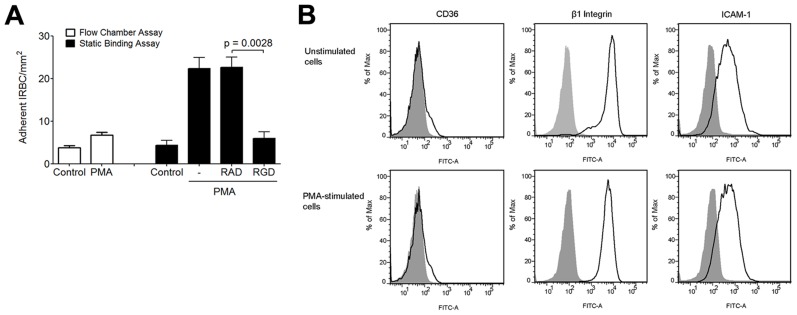
Effect of PMA on IRBC adhesion to HMEC-1.(A) Adhesion of IRBC on untreated HMEC-1 or HMEC-1 pre-incubated with PMA 50 ng/ml for 30 min at 37°C and 5%CO2 under flow (left) or static (right) conditions. In the static binding experiments, monolayers were pre-treated with either 50 ng/ml of PMA alone, or 100 µM RGD or RAD peptide was added after 10 min of incubation. At the end of 30 min, 1 ml of a 1% hematocrit suspension of IRBC in RPMI at 5–9% parasitemia was added and allowed to adhere for 20 min. The 35 mm dish with the HMEC-1 monolayer and IRBC was then mounted into the flow chamber system. HBSS was infused at 1 dyne/cm2, and the number of adherent cells were counted at 30 sec intervals for a total of 4 min and the mean taken (n = 3). (B) CD36, β1 integrin and ICAM-1 expression on control and PMA-treated HMEC-1 cells. Results are representative of 2 independent experiments.